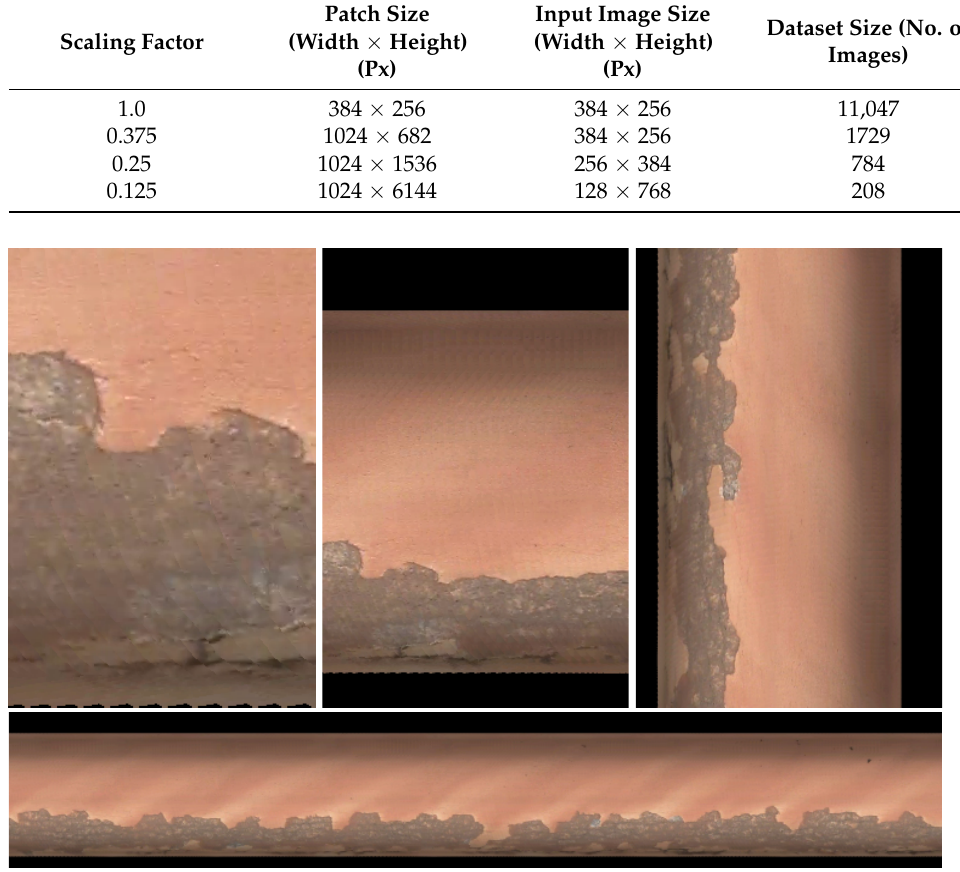
Figure 2. Example images of the used datasets with the different downscaling factors (see Table 1). Upper left : 384 × 256 pixels (rotated) without downscaling; center : 384 × 256 pixels (rotated) with a scaling factor of 0.375; upper right : 256 × 384 pixels with a scaling factor of 0.25; bot- tom : 128 × 768 pixels (rotated) with a scaling factor of